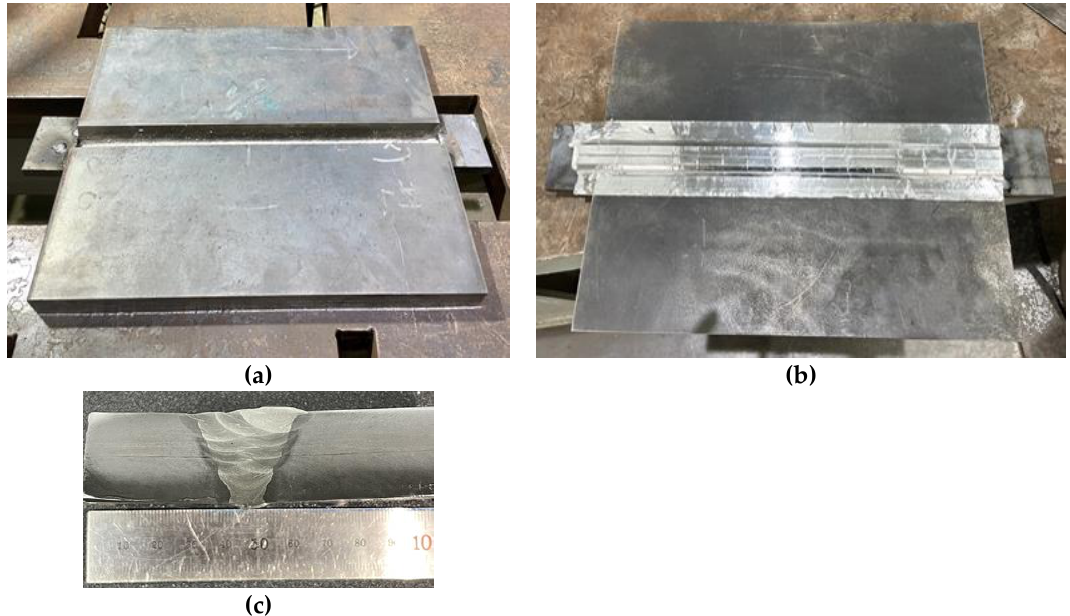
Figure 3. Unconstrained condition of specimens. ( a ) End tap; ( b ) ceramic backing; ( c ) macro sec- tion.